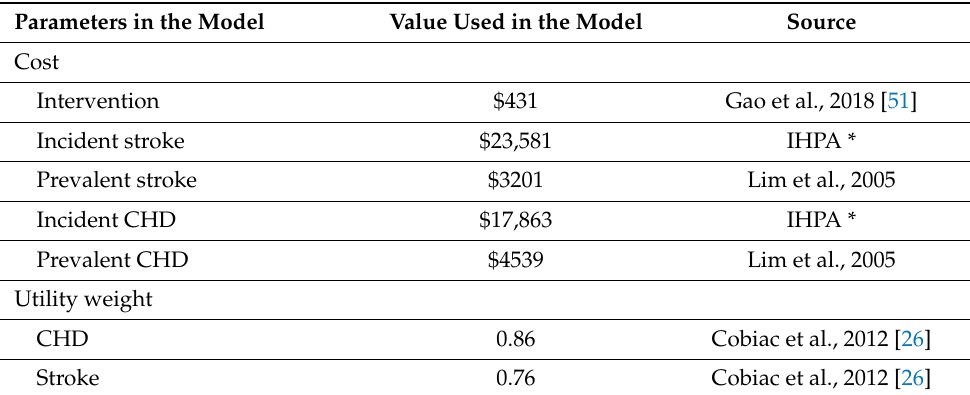
Table A1. Model Parameters.